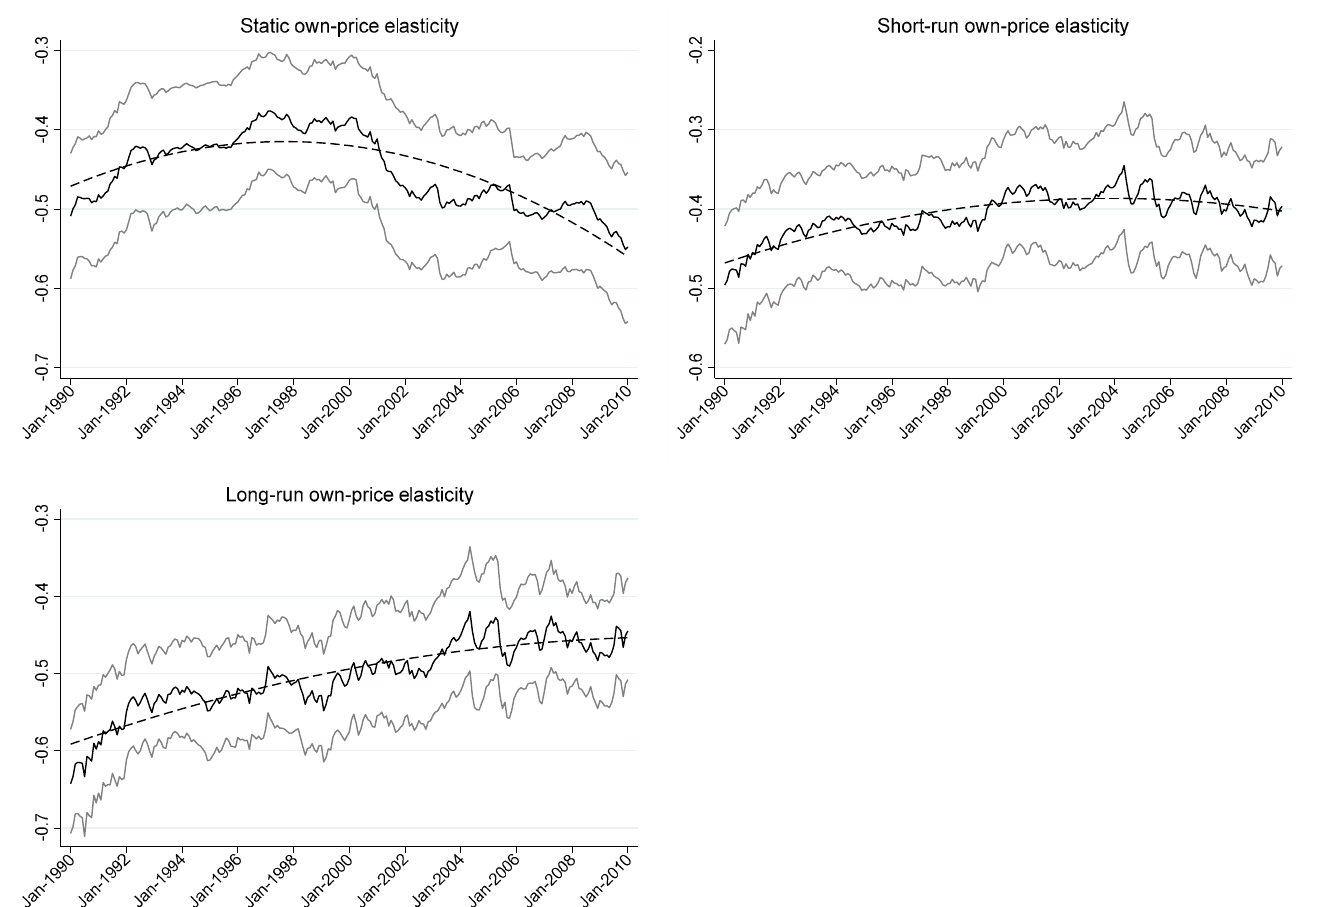
Figure 2. Rolling-window own-prices elasticity estimates. The solid black line portrays an elasticity estimate; the lower and upper solid grey lines show the 95% confidence interval; and the dashed line is the time trend of the estimate.